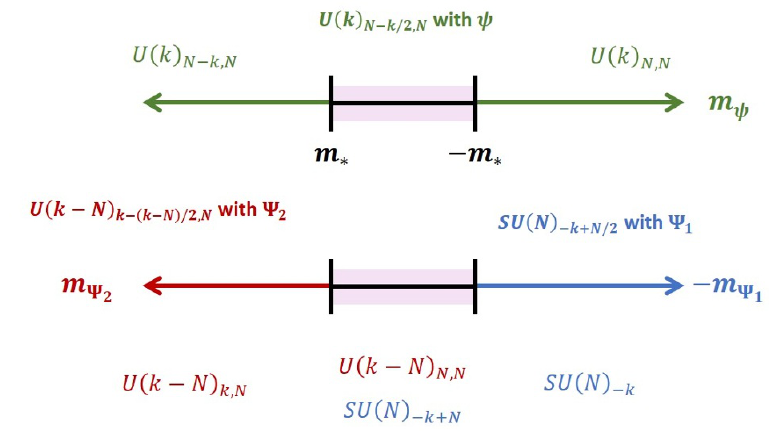
Figure 6 . Phase diagram for the novel real adjoint bosonization